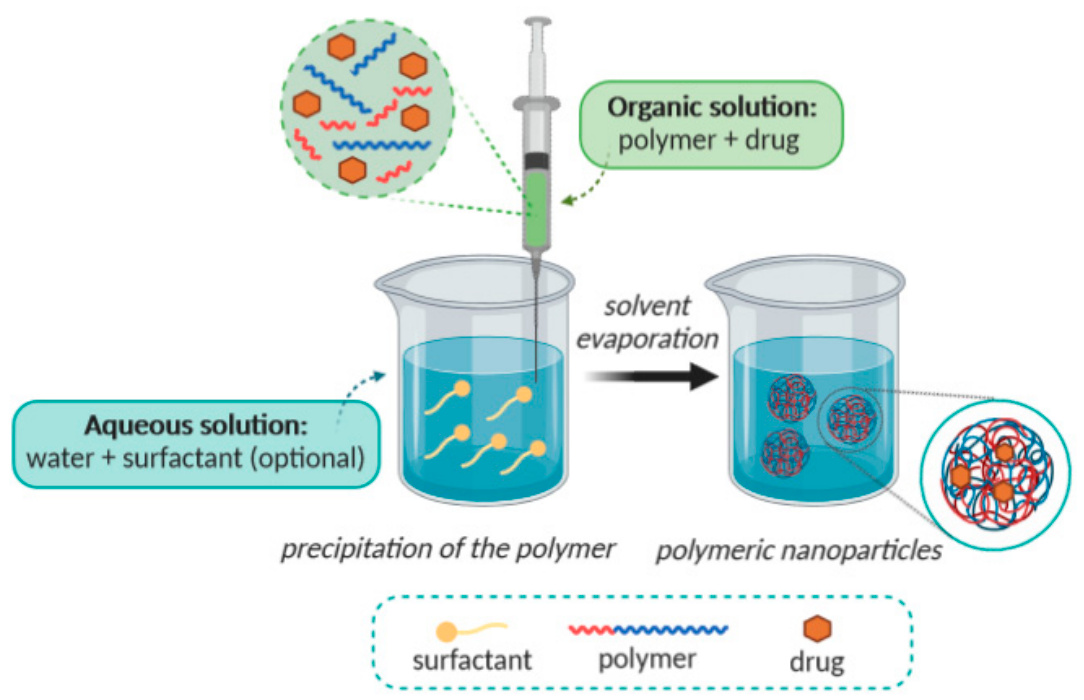
Figure 5. Schematic illustration of the nanoprecipitation method.